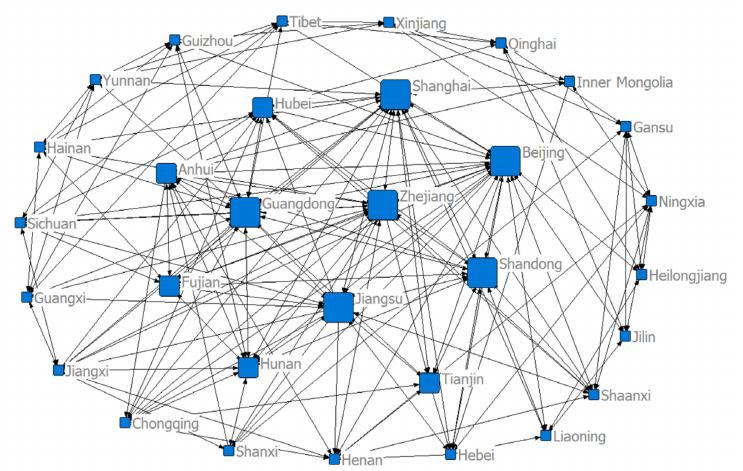
Figure 4. Structure of the spatial correlation network of health resource agglomeration capacities in China in 2004.